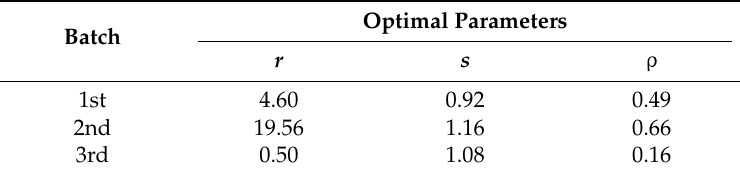
Table 4. The optimal parameters of the multi-kernel relevance vector machine